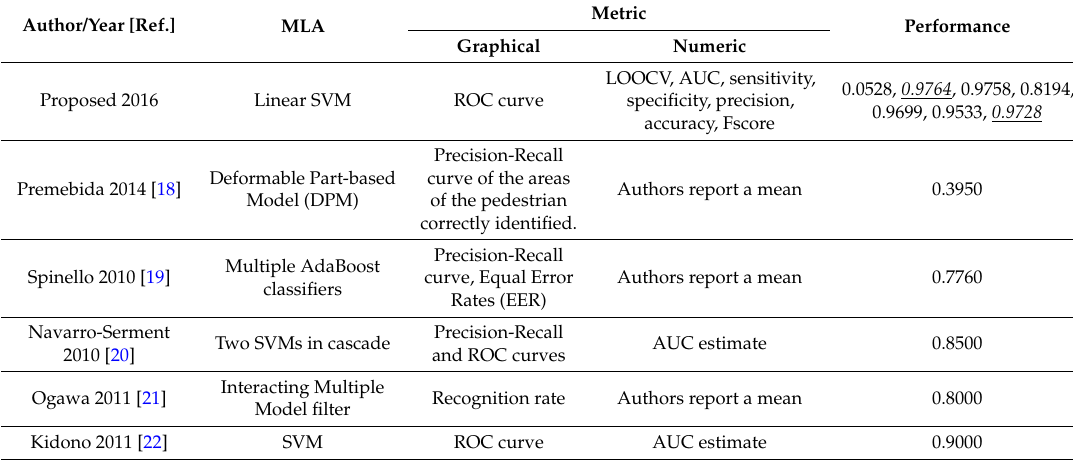
Table 6. Comparison of proposed method with other authors.